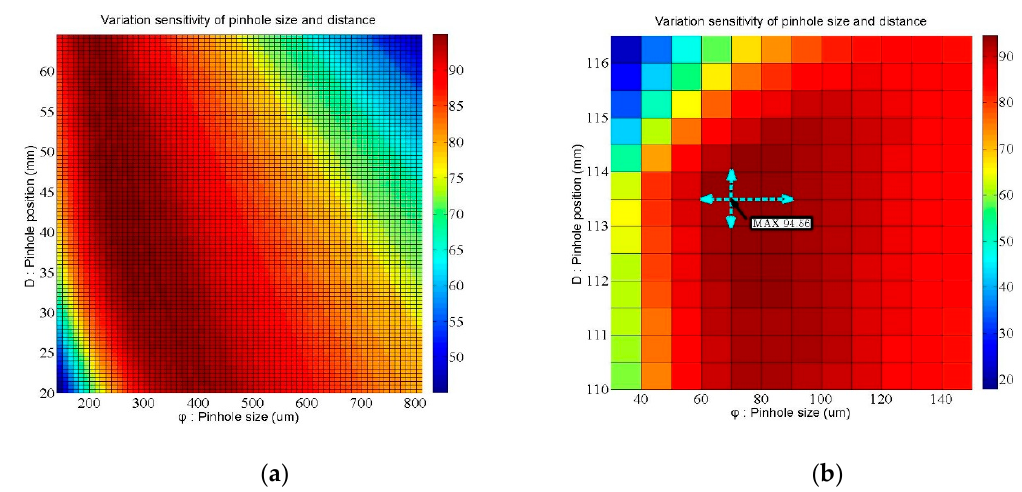
Figure 8. Simulation results of the variation in sensitivity of the autofocusing system depending on ( a ) the position of rear focal point and ( b ) the position of front focal point.